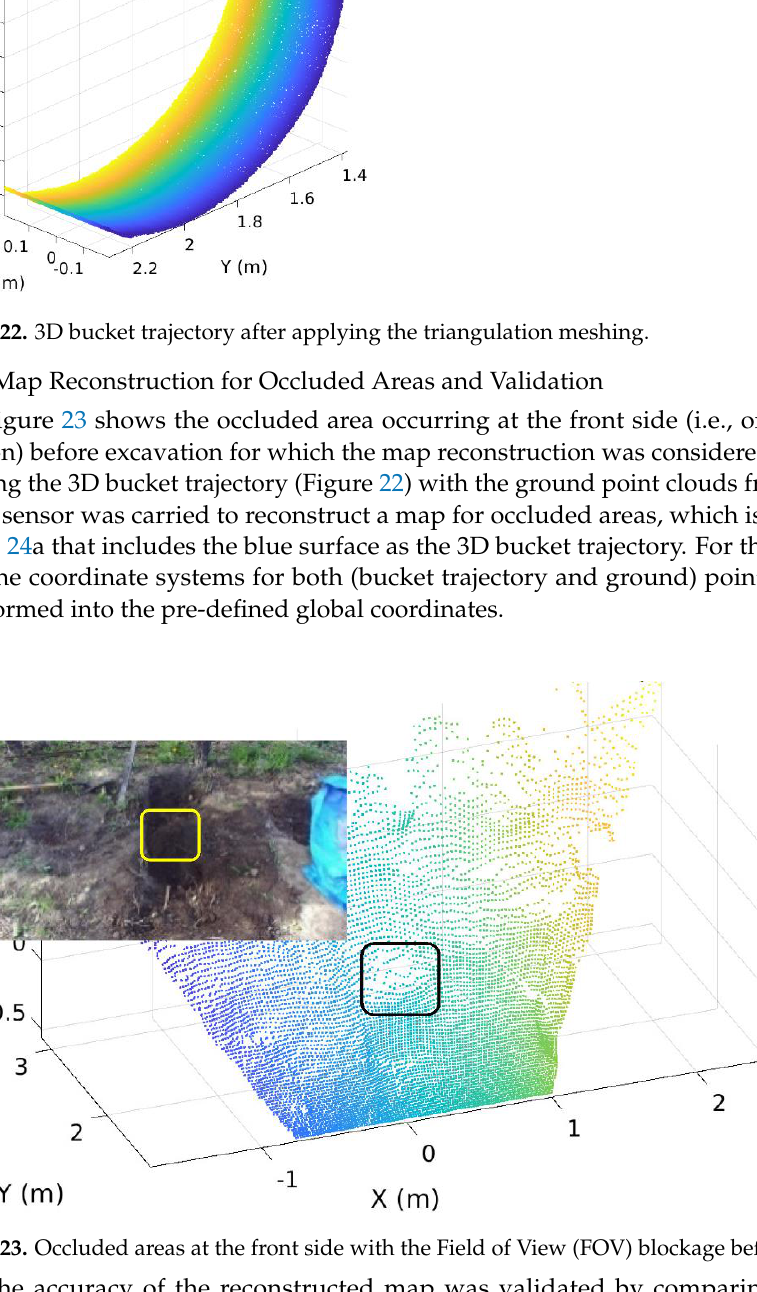
Figure 21. The identified bucket trajectory: ( a ) 2D bucket trajectory; ( b ) Converted 3D bucket trajectory by considering the bucket width.